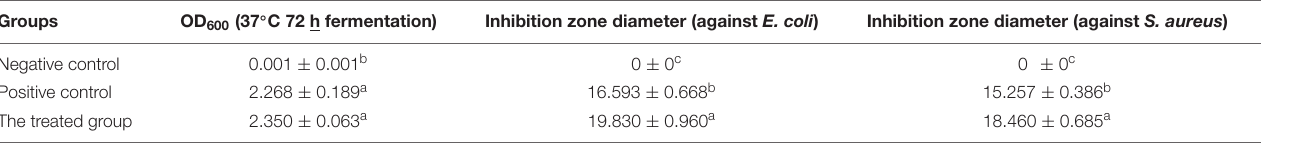
TABLE 1 | Antibacterial activity of lacidophilin.